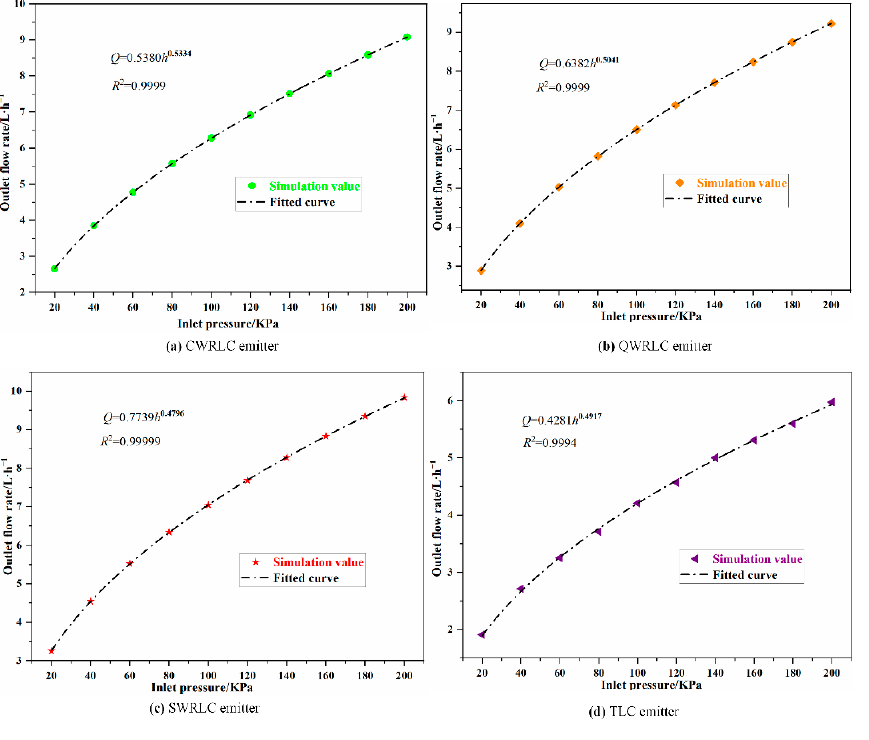
Figure 10. Schematic diagram and velocity vector distribution of the flow channel structures under 100 KPa.